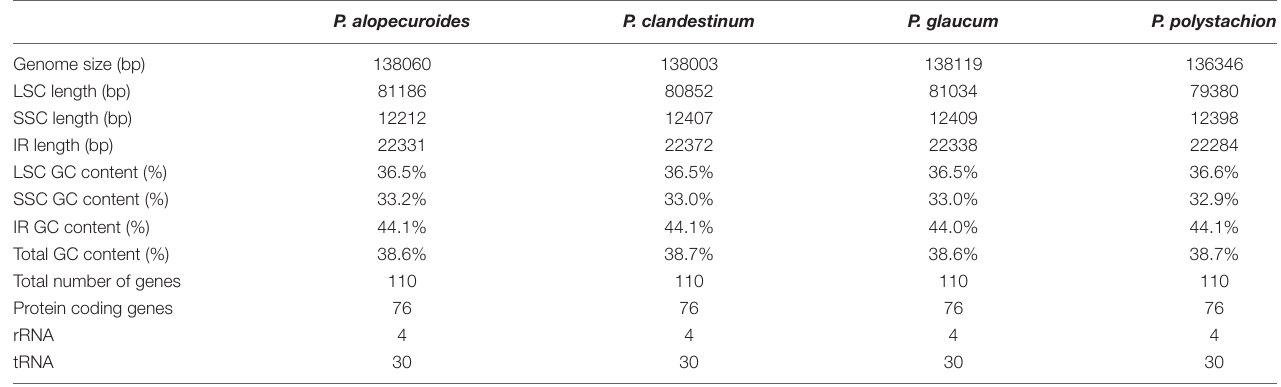
TABLE 1 | Summary statistics for the assembly of the chloroplast genomes of four Pennisetum species.